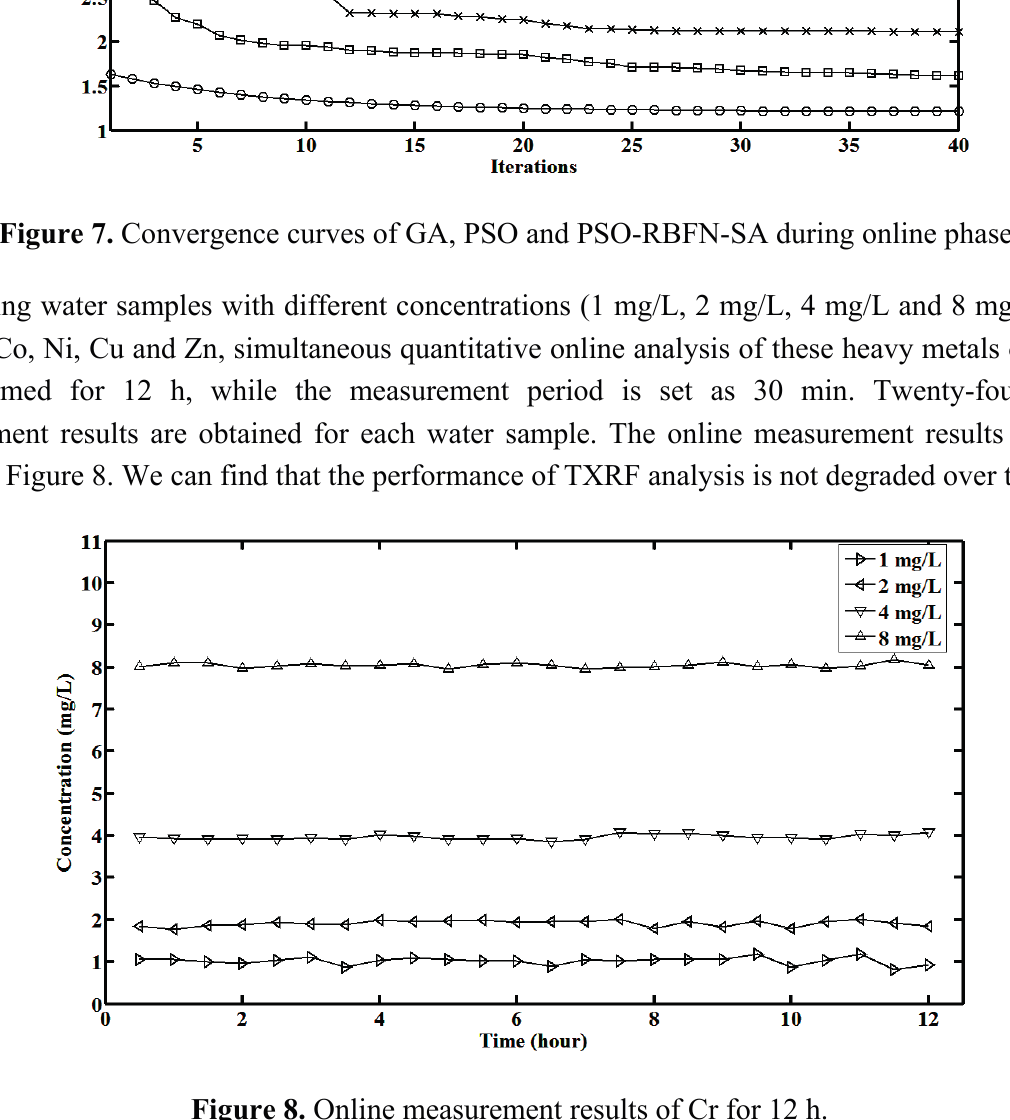
Figure 8. Online measurement results of Cr for 12